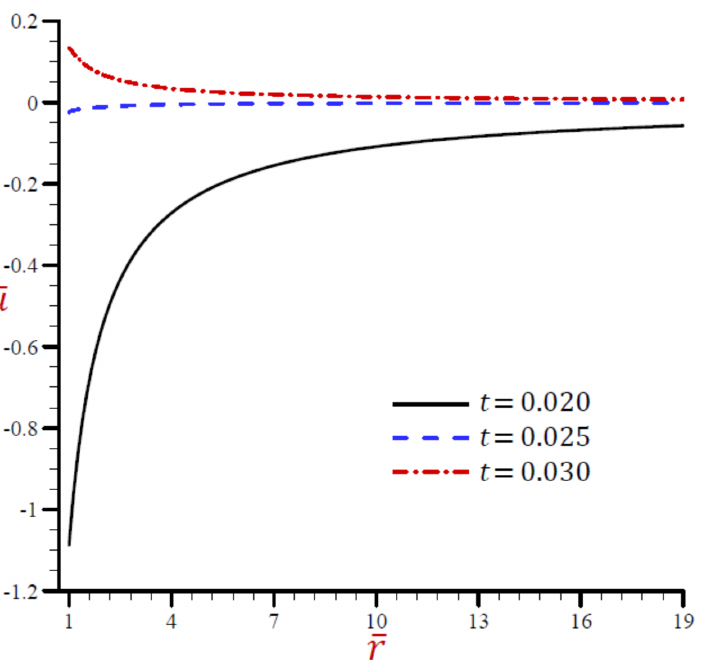
Figure 21. Effect of t on radial displacement u across the radial direction of the cylindrical cavity utilizing the RDPL